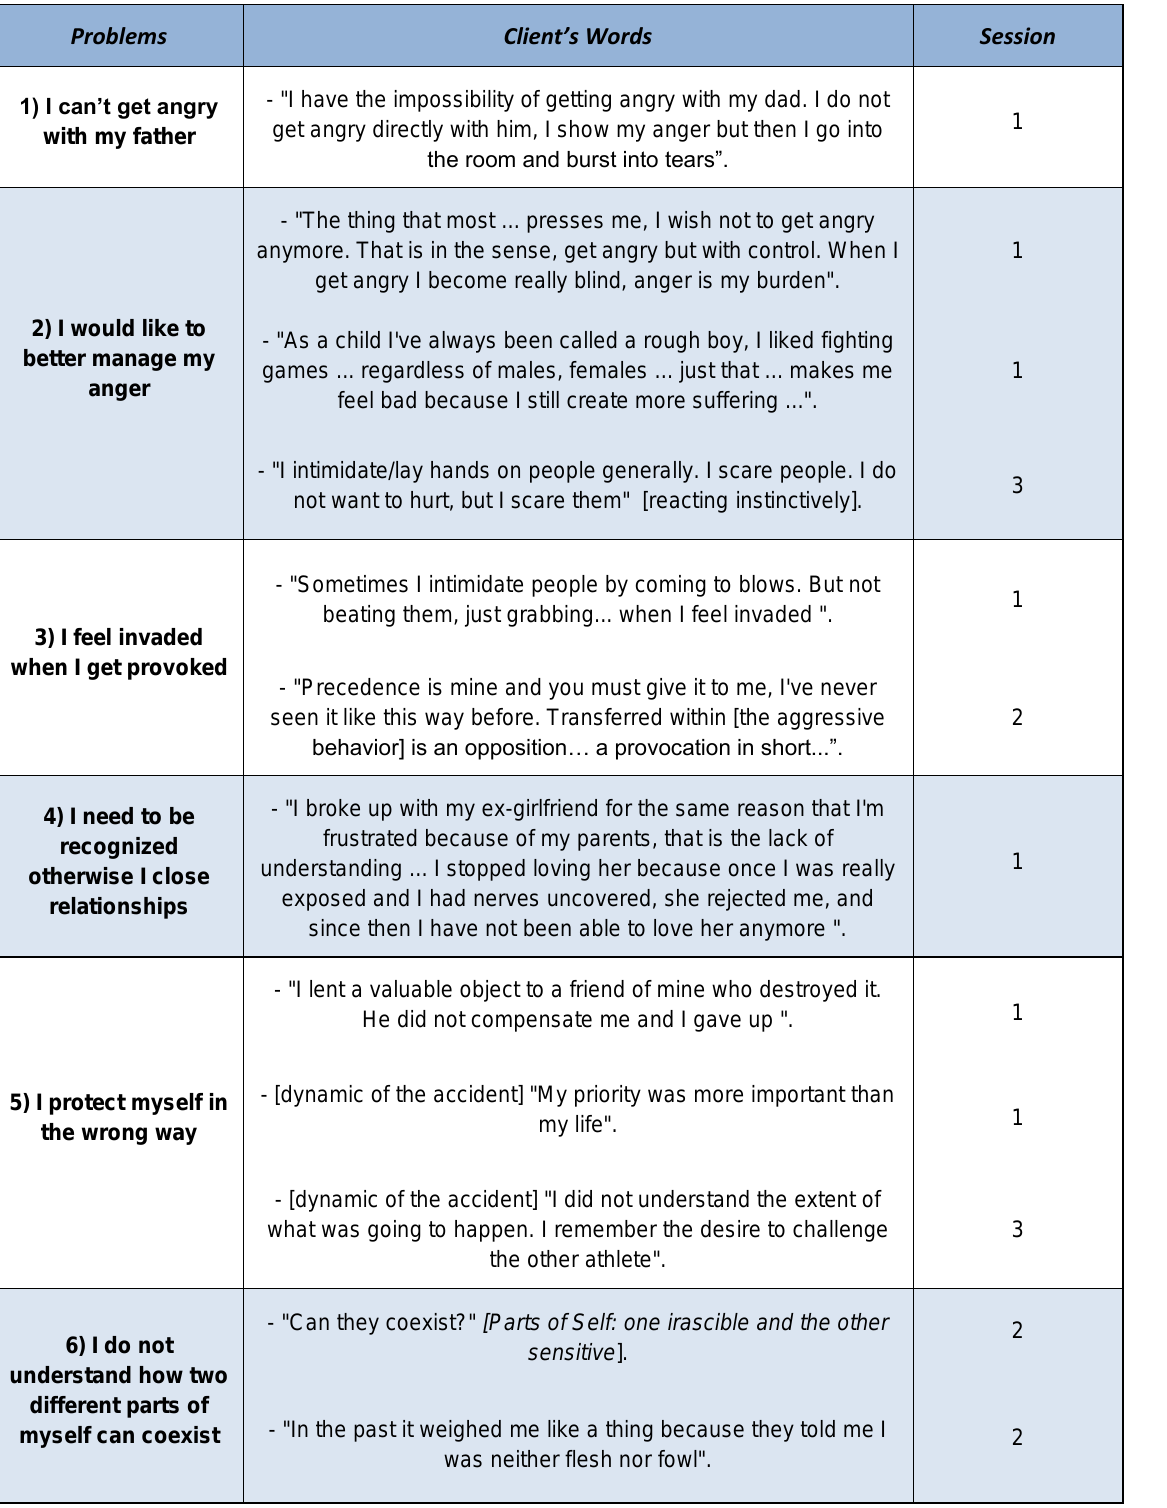
Table 4: Core problems or sufferings: Client’s Examples during Phase 1-3 Initial